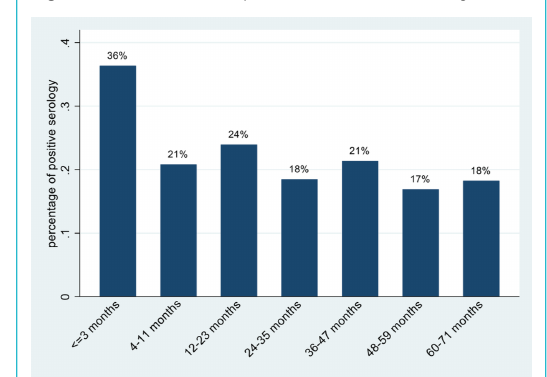
Figure 2: SARS-CoV-2 seroprevalence as a function of age.